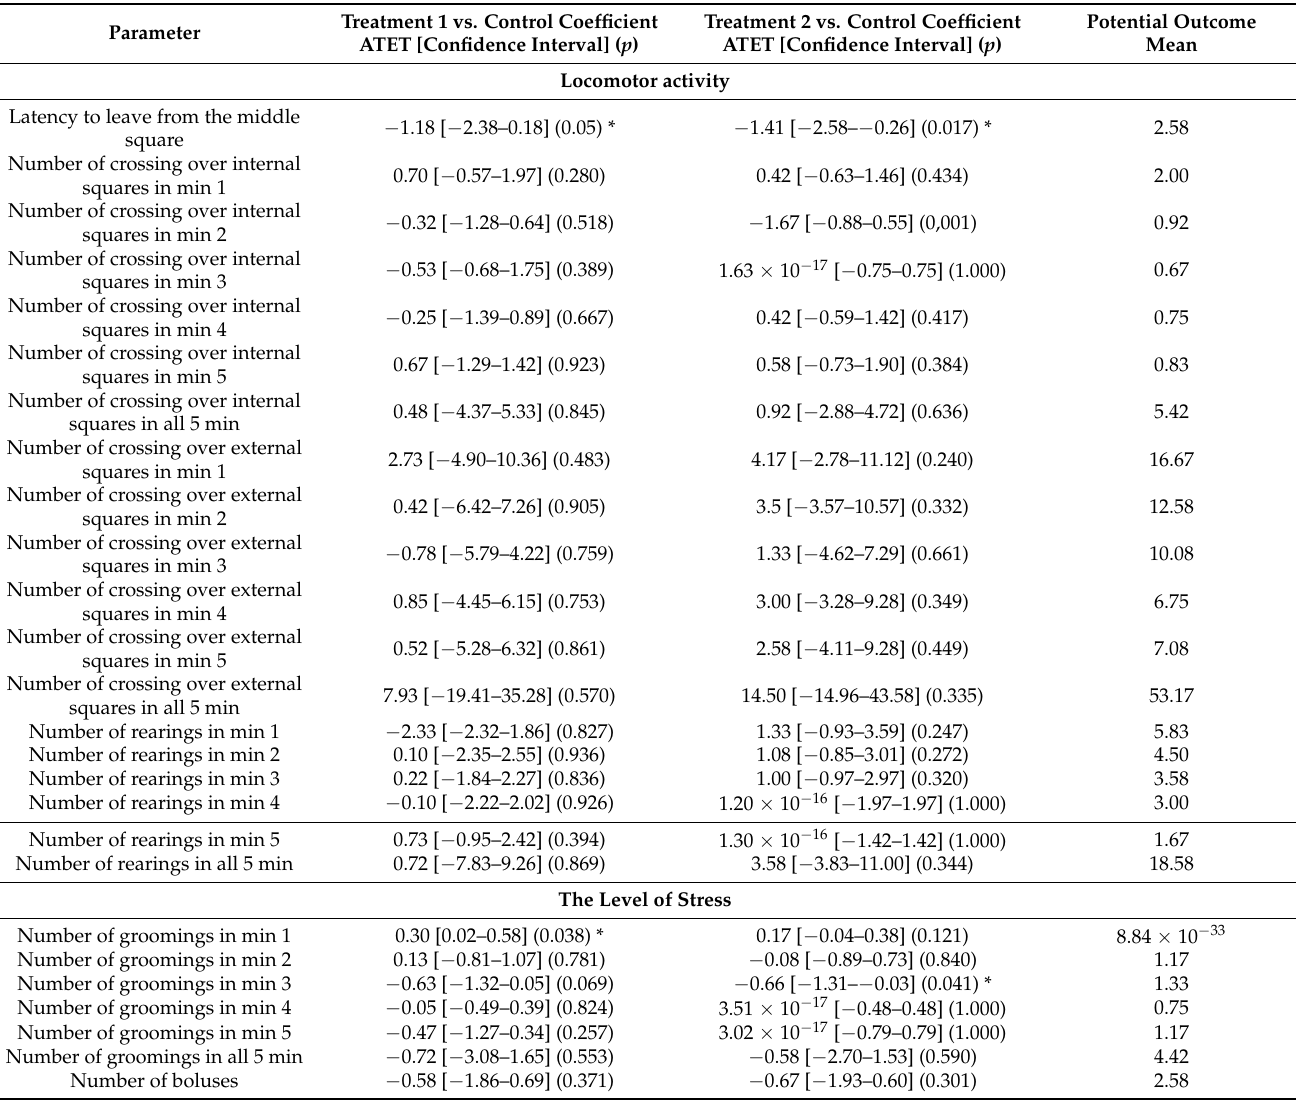
Table 3. Averaged treatment effects for open field